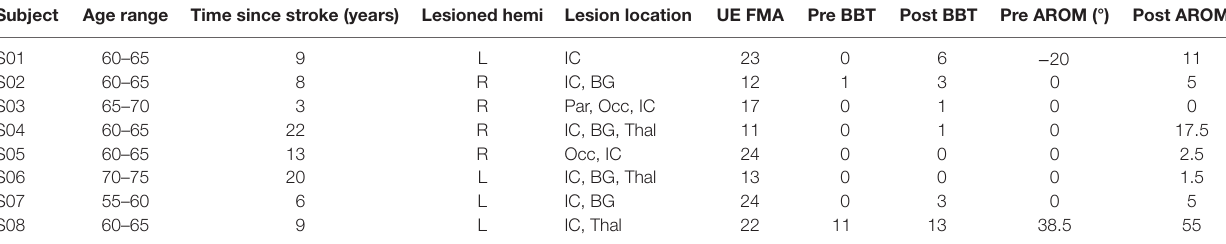
TaBle 1 | Subject demographics and clinical